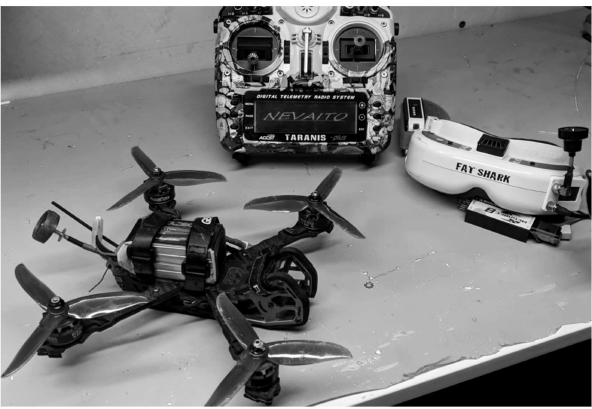
Figure 1. UAV (unmanned aerial vehicle) used for remote